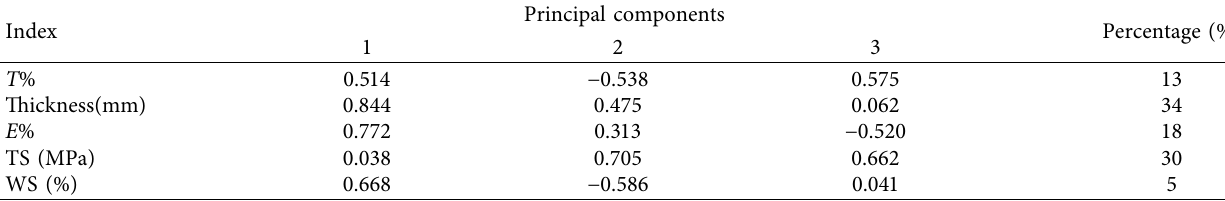
− indicated negative correlative.